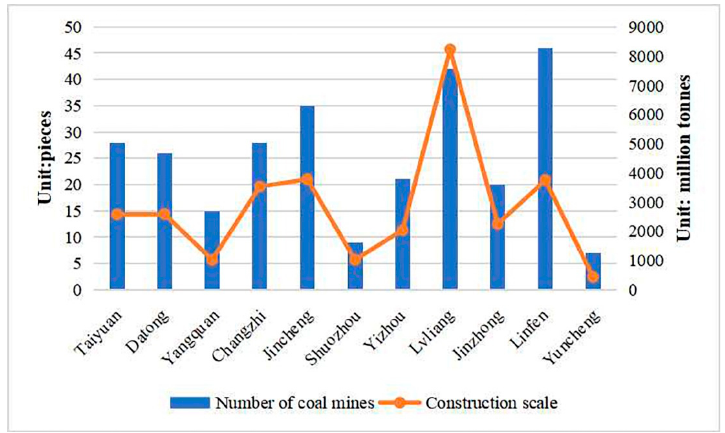
Figure 5. Number of coal mines under construction and construction scale in Shanxi Province.